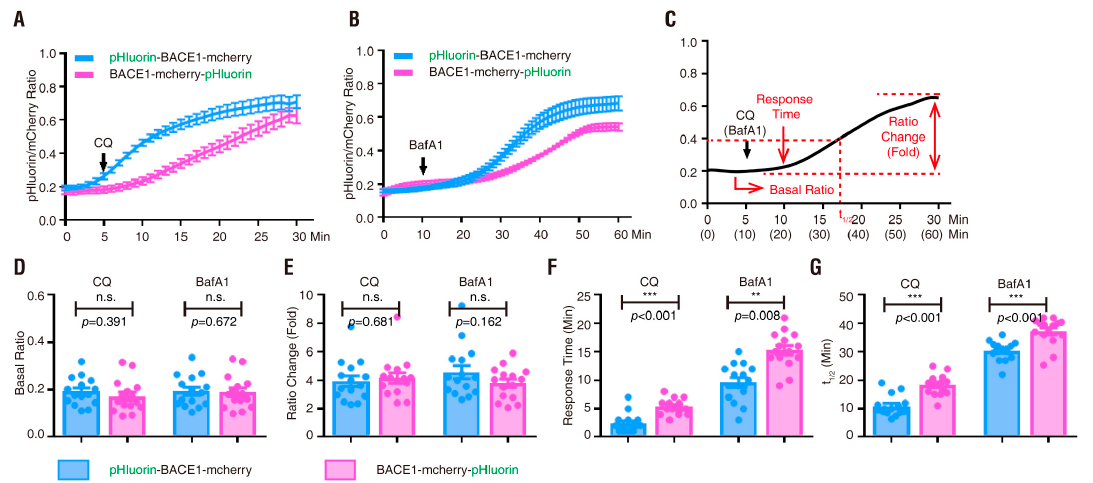
Figure 7. Summary of BACE1 fusion proteins in response to CQ and BafA1 in primary cortical neurons